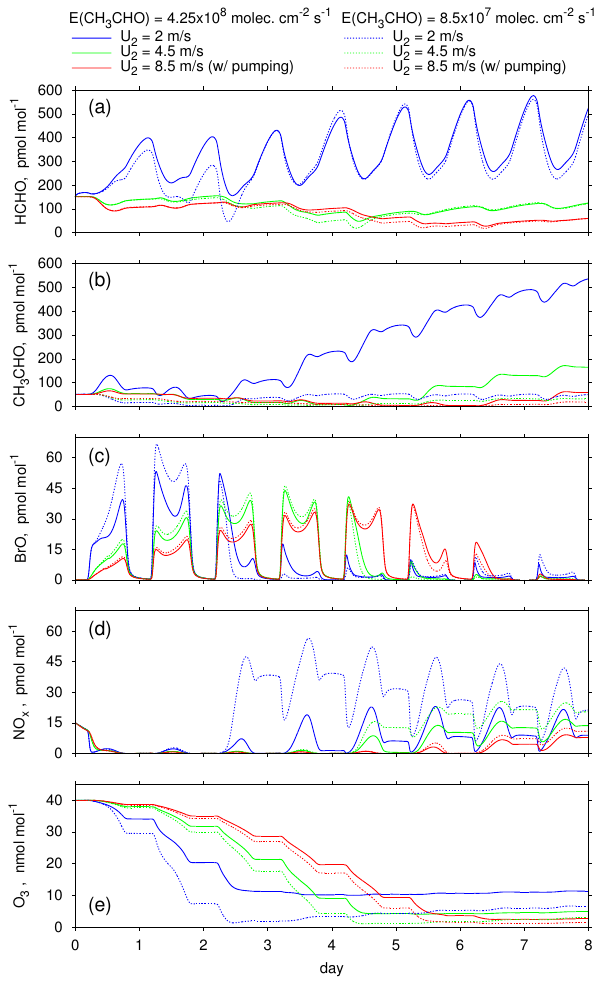
Fig. 5. Simulated mixing ratios of (a) HCHO, (b) CH 3 CHO, (c) BrO, (d) NO x ( = NO + NO 2 ), and (e) O 3 at z = 1 . 5m (ambi- ent air) from model runs with snowpack emissions of CH 3 CHO at “standard” (solid lines) and “low” (dotted lines) rates and with U 2 assigned at either 2ms − 1 (blue), 4.5ms − 1 (green), or 8.5ms − 1